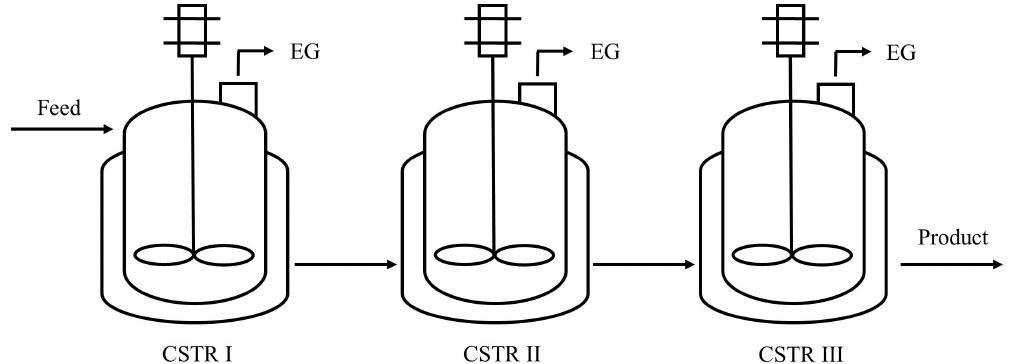
Figure 3. Schematic of three CSTRs in series in the polycondensation stage.